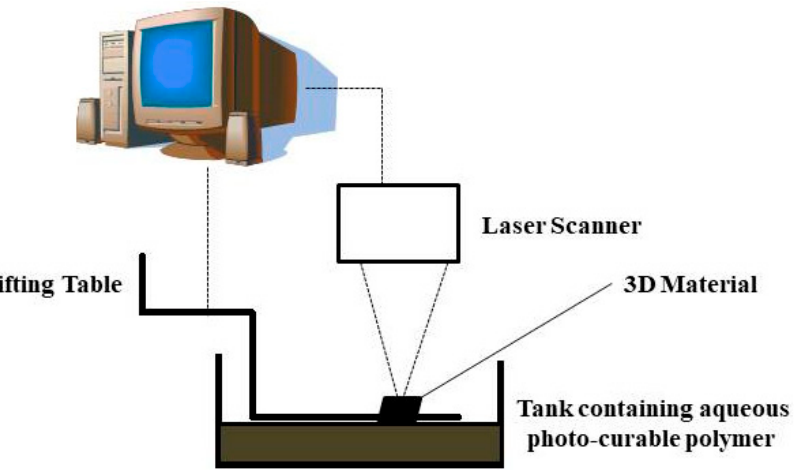
Figure 11. Simplified diagram of stereolithography, which consists of a tank, lifting table, laser scanner, and a computer.